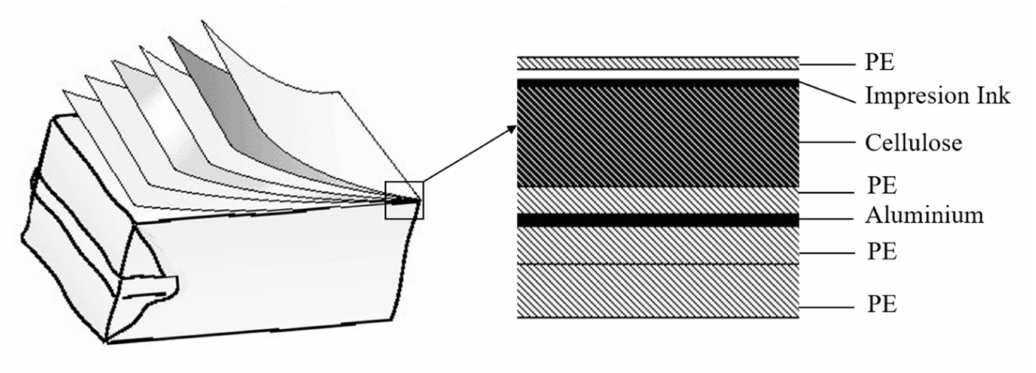
Figure 1. Aseptic cardboards (UHT